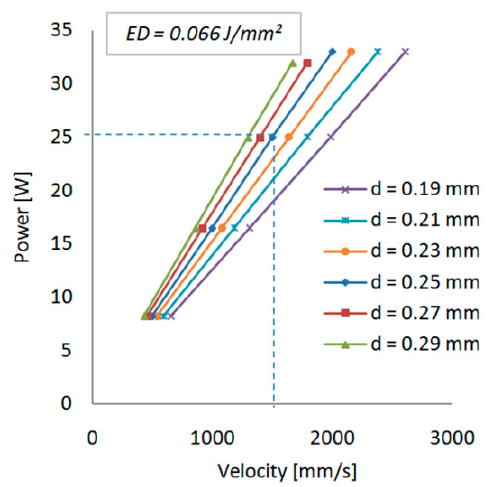
Figure 2. Linear dependency of parameters that create the energy density.